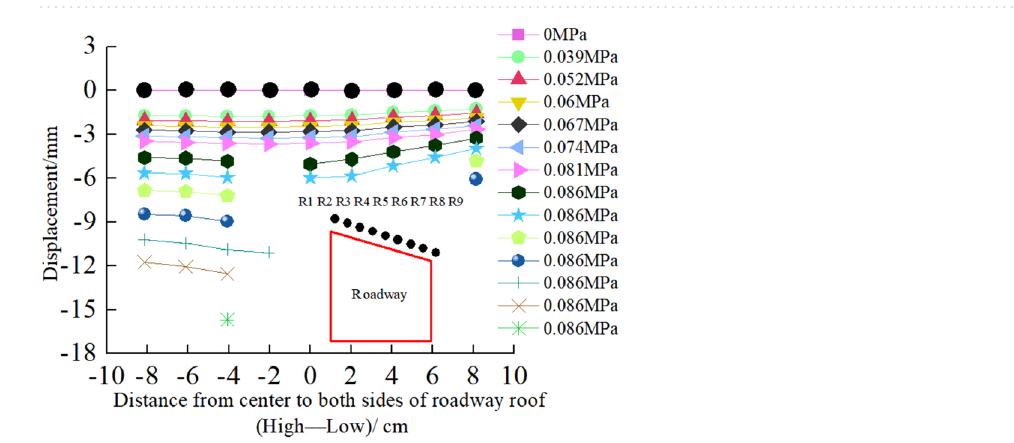
Figure 8. Displacement nephogram of all measuring points on both sides of roadway at 0.063 MPa.